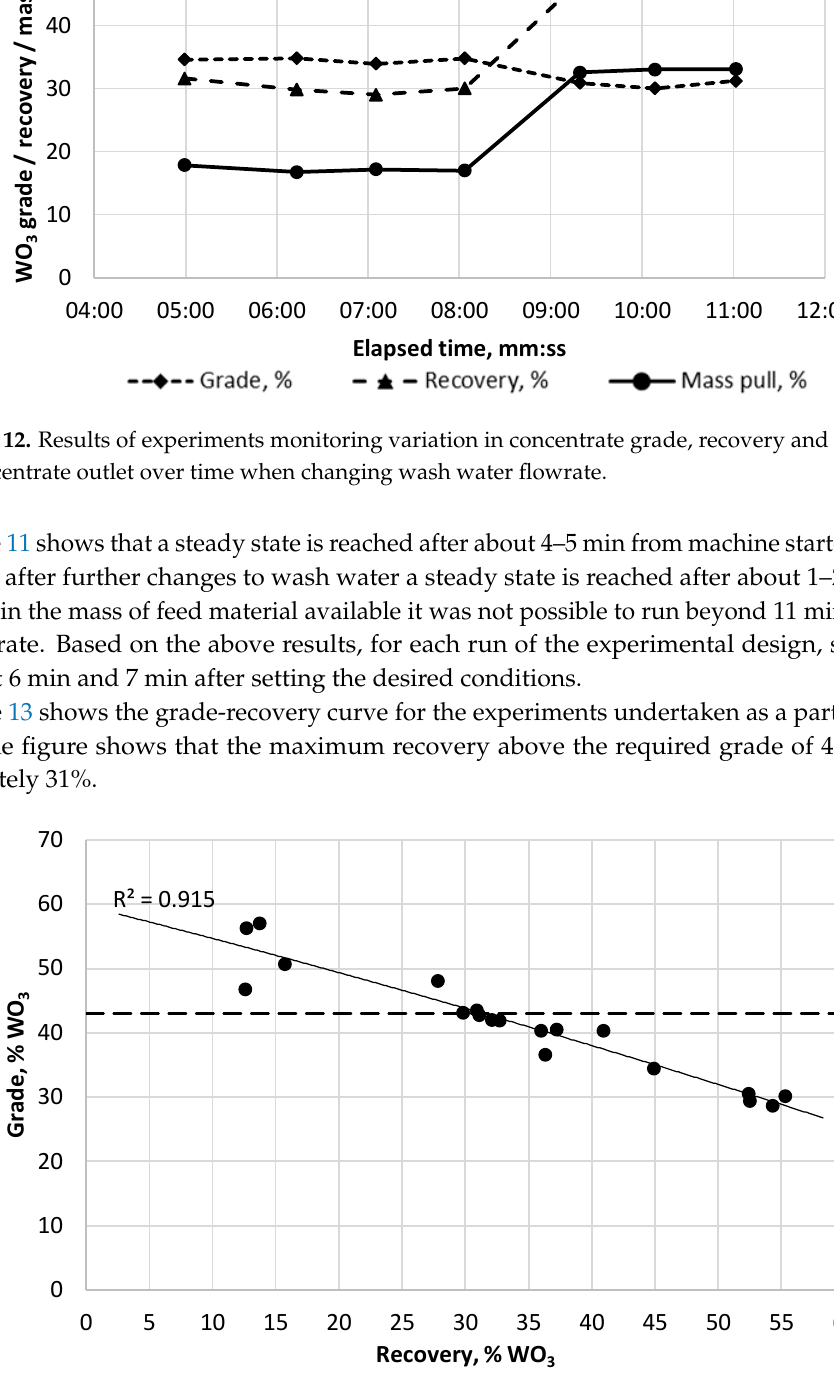
Figure 11. Results of experiments to monitor variation in concentrate grade, recovery and mass pull to concentrate outlet over time.